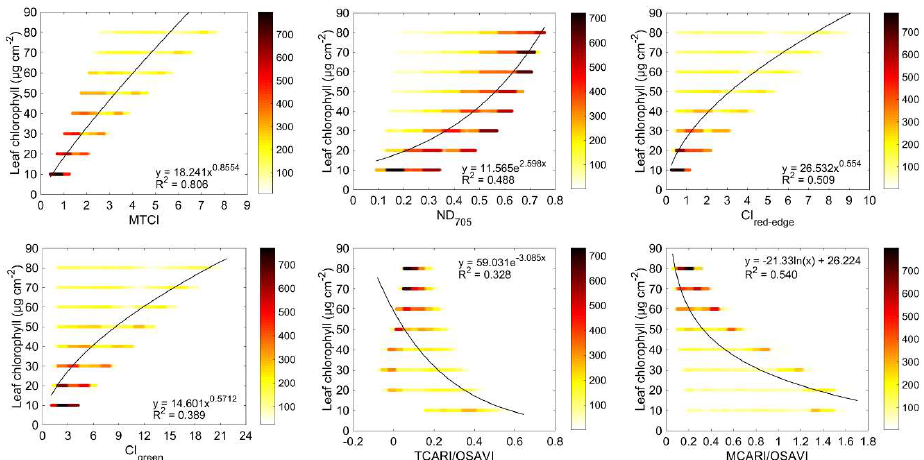
Figure 7. Relationships obtained between LCC and the indices MTCI, ND 705 , CI red-edge , CI green TCARI/OSAVI and MCARI/OSAVI calculated from the simulated dataset. Remote Sens. 2020 , 12 , x FOR PEER REVIEW